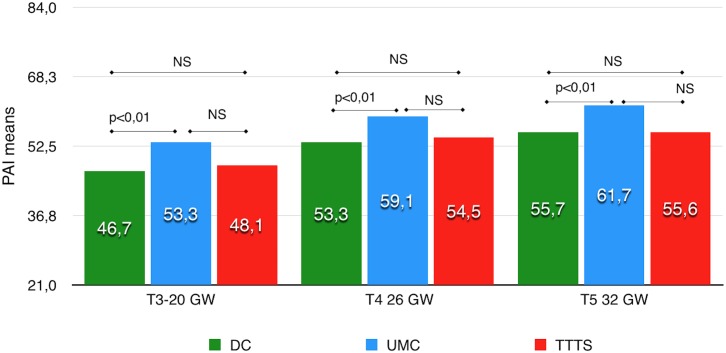
PAI inter-groups.